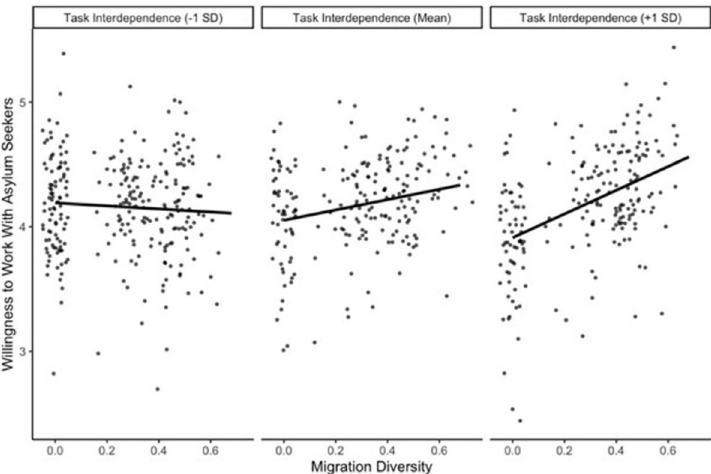
Fig 3. Significant interaction effect of task interdependence and migration background diversity on willingness to collaborate with asylum seekers, controlled for control variables.